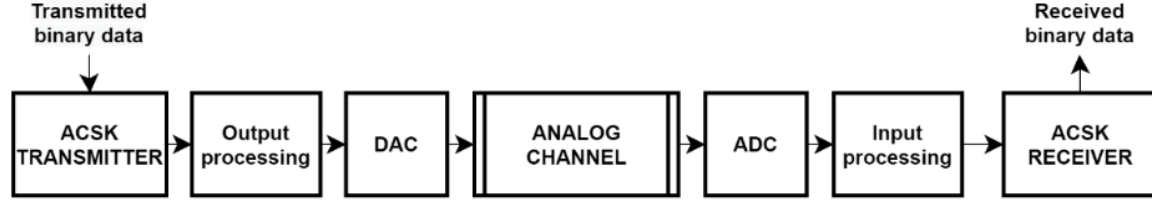
Figure 1. Simplified structure of the proposed chaotic communication system.